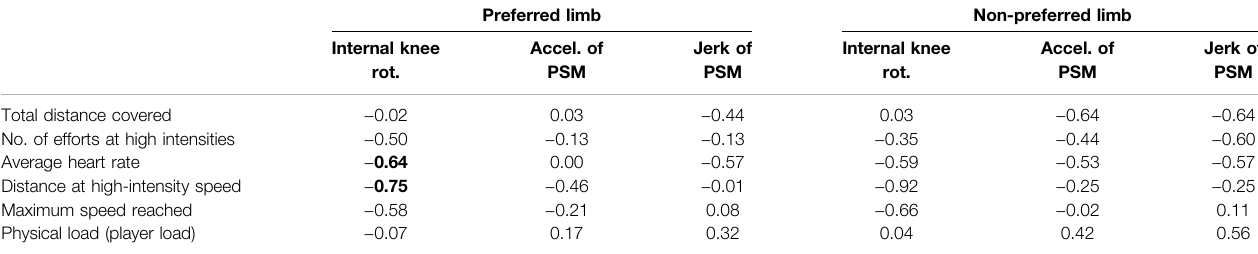
TABLE 3 | Correlation matrix between performance parameters and knee